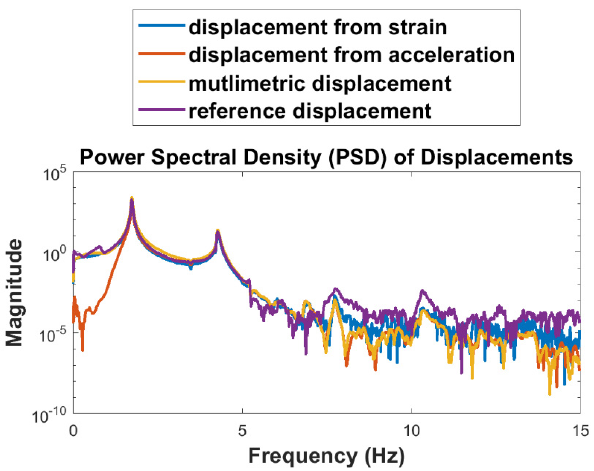
Figure 10. Comparison of estimated and reference first-story displacement in frequency domain.